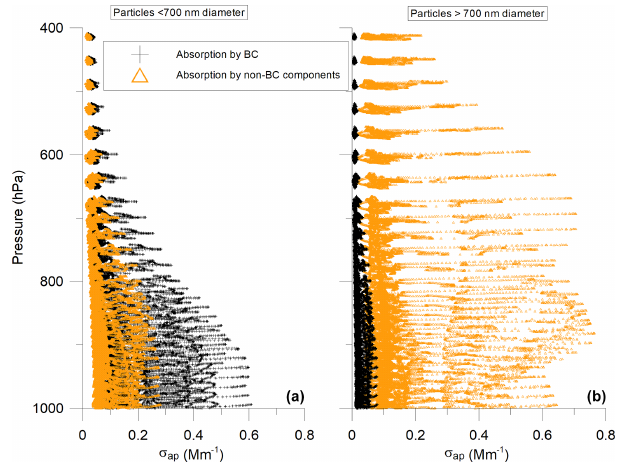
Figure 7. Modelled profile data of the contributions to absorp- tion from BC (black crosses) and non-BC-absorbing components (orange triangles) for (a) particles less than 700nm diameter and (b) particles > 700nm diameter. The simulations are for the NW Alert grid box and based on an external mixture.